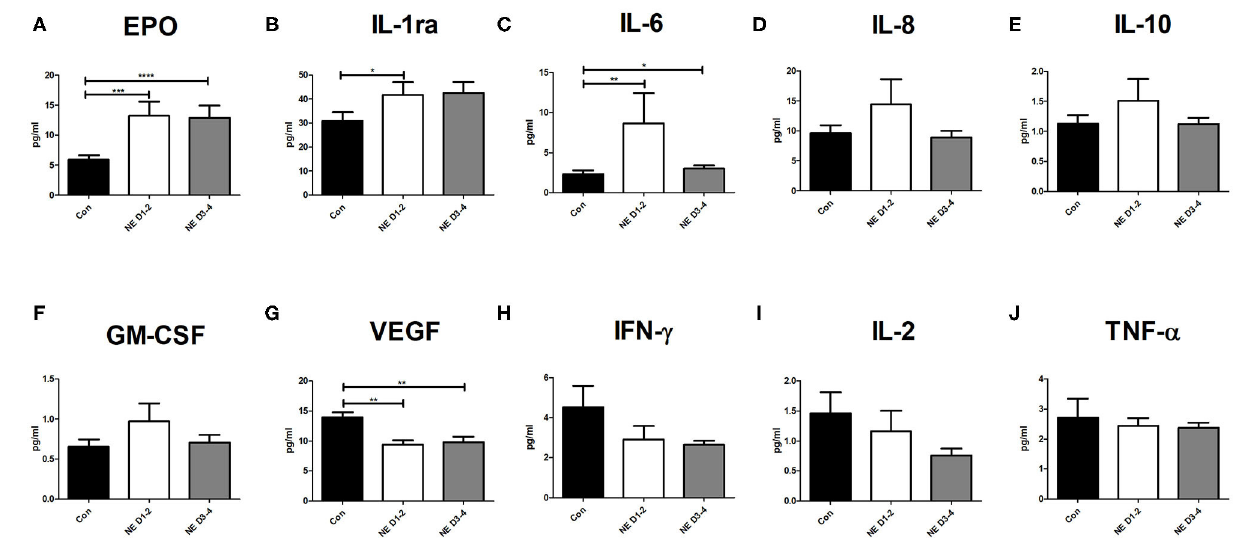
FIGURE 1 | Cytokine levels in NE and control at baseline. Whole blood sampling was performed in the 1st week of life, and a 14-spot ELISA Multiplex Cytokine Array was performed. Graphs represent pg/ml of each cytokine measured in samples of control, NE days 1–2, and NE days 3–4. Cytokines measured are (A) Epo, (B) IL-1ra, (C) IL-6, (D) IL-8, (E) IL-10, (F) GM-CSF, (G) VEGF, (H) IFN- γ , (I) IL-2, and (J) TNF- α . p* = p < 0.05, p** = p < 0.01, p*** = p < 0.001, p**** = p < 0.0001. NE, neonatal encephalopathy; Epo, erythropoietin; IL, interleukin; GM-CSF, granulocyte-macrophage colony-stimulating factor; VEGF, vascular endothelial